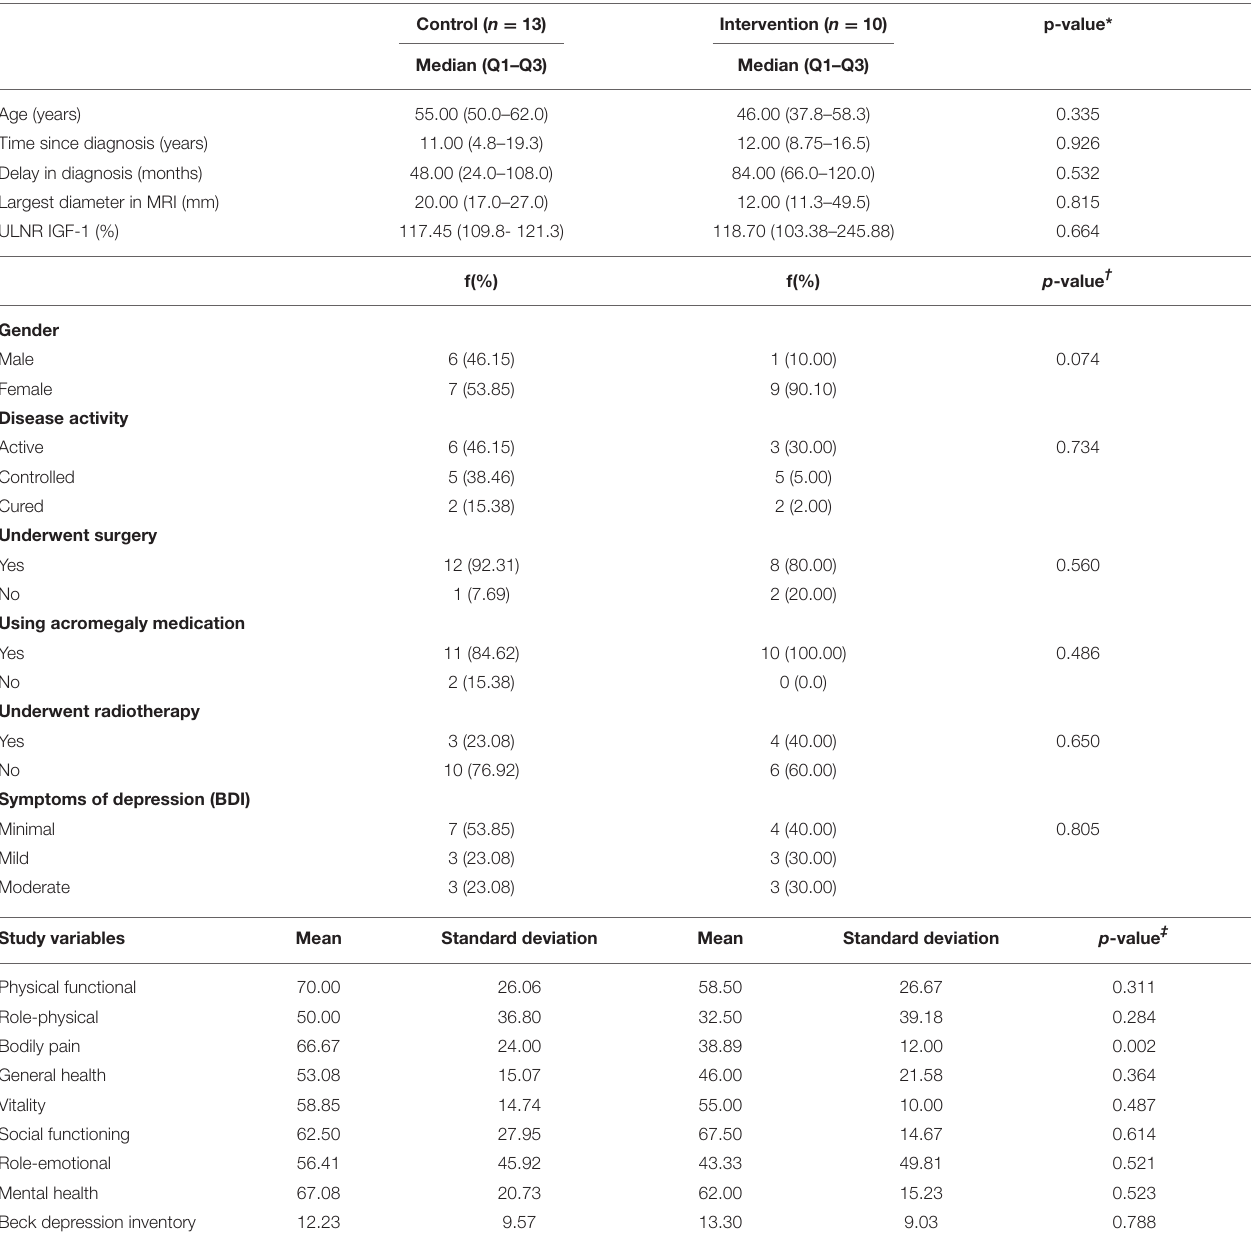
TABLE 1 | Comparison between the control group and the intervention group in relation to age, gender, the clinical and laboratory aspects of the disease, and the study variables in the baseline ( n =